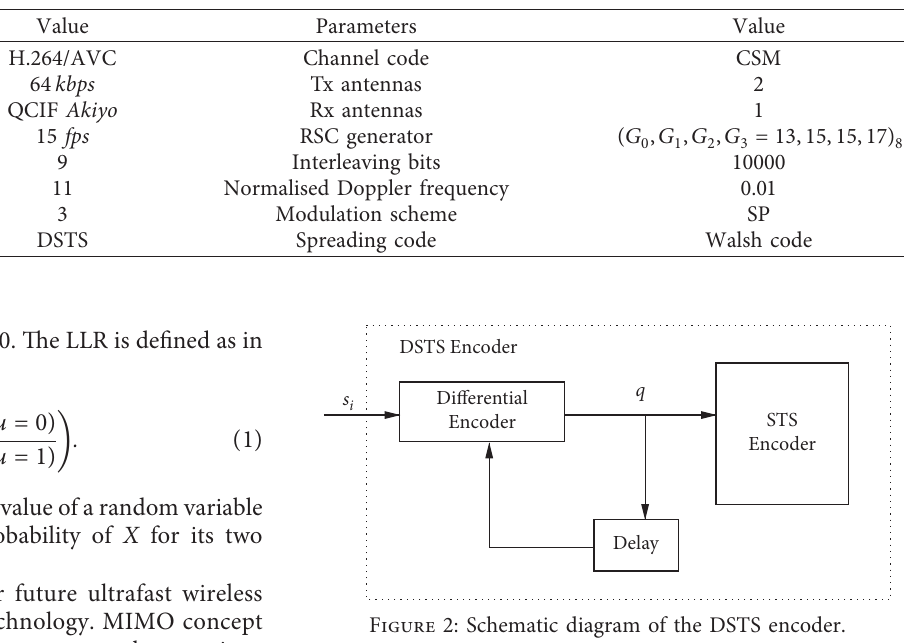
Figure 1: Block diagram of the proposed DSTS-SP aided iterative JSCD system. Table 1: Proposed DSTS-SP-assisted CSM system parameters.